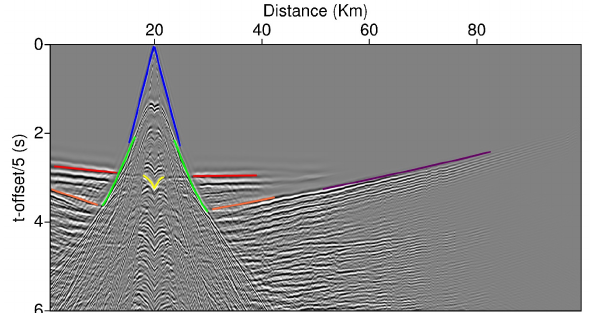
Fig. 3. Velocity model obtained using TTT package Trinks et al. (2005) considering only first arrivals. Interfaces between layers are the ones that were used in the theoretical model. Velocities over the basalt wedge are well constrained. A prominent velocity discontinuity can be observed for the first 70 km between 3 and 4 km in depth which provides the location for the top of basalt layer. A 1 dimensional five layer-cake model was used as the starting model (water, sediments, a wedge of basalt, sediments and basement). Note that the interface between the sediment and the underlying basalt was determined using only the first arrivals. No significant differences in the final model were observed by changing the velocity model 20% in the velocities and 15% in the layer finickinesses. The unresolved parts of the model at both ends of the transect are determined from forward modelling, ray tracing.